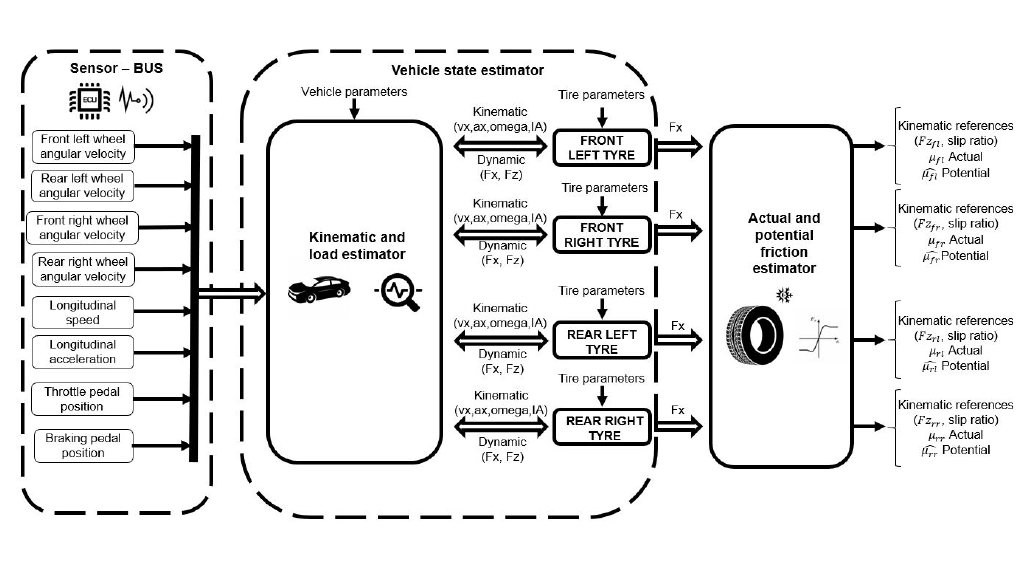
Figure 5. Architecture of the vehicle state estimation